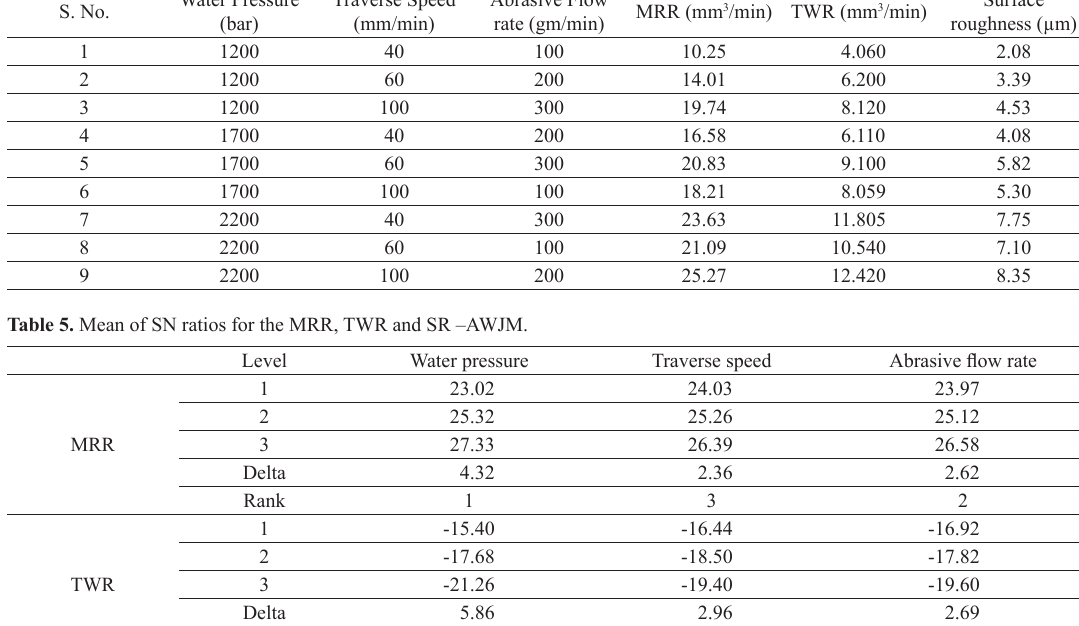
Table 4. Abrasive water jet machining experimental results. S. No.